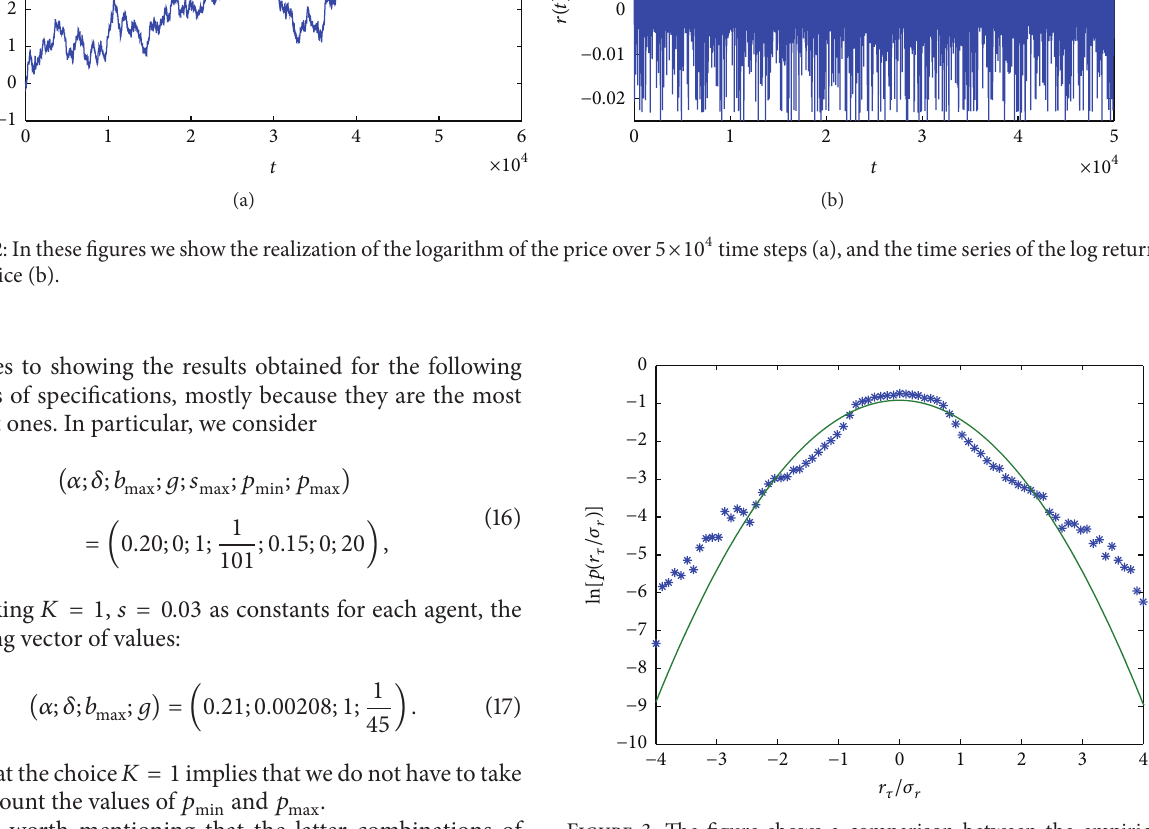
Figure 3: The figure shows a comparison between the empirical distribution of the log returns, considering 𝜏 = 8 ( ∗ -line), and the Gaussian standard distribution.